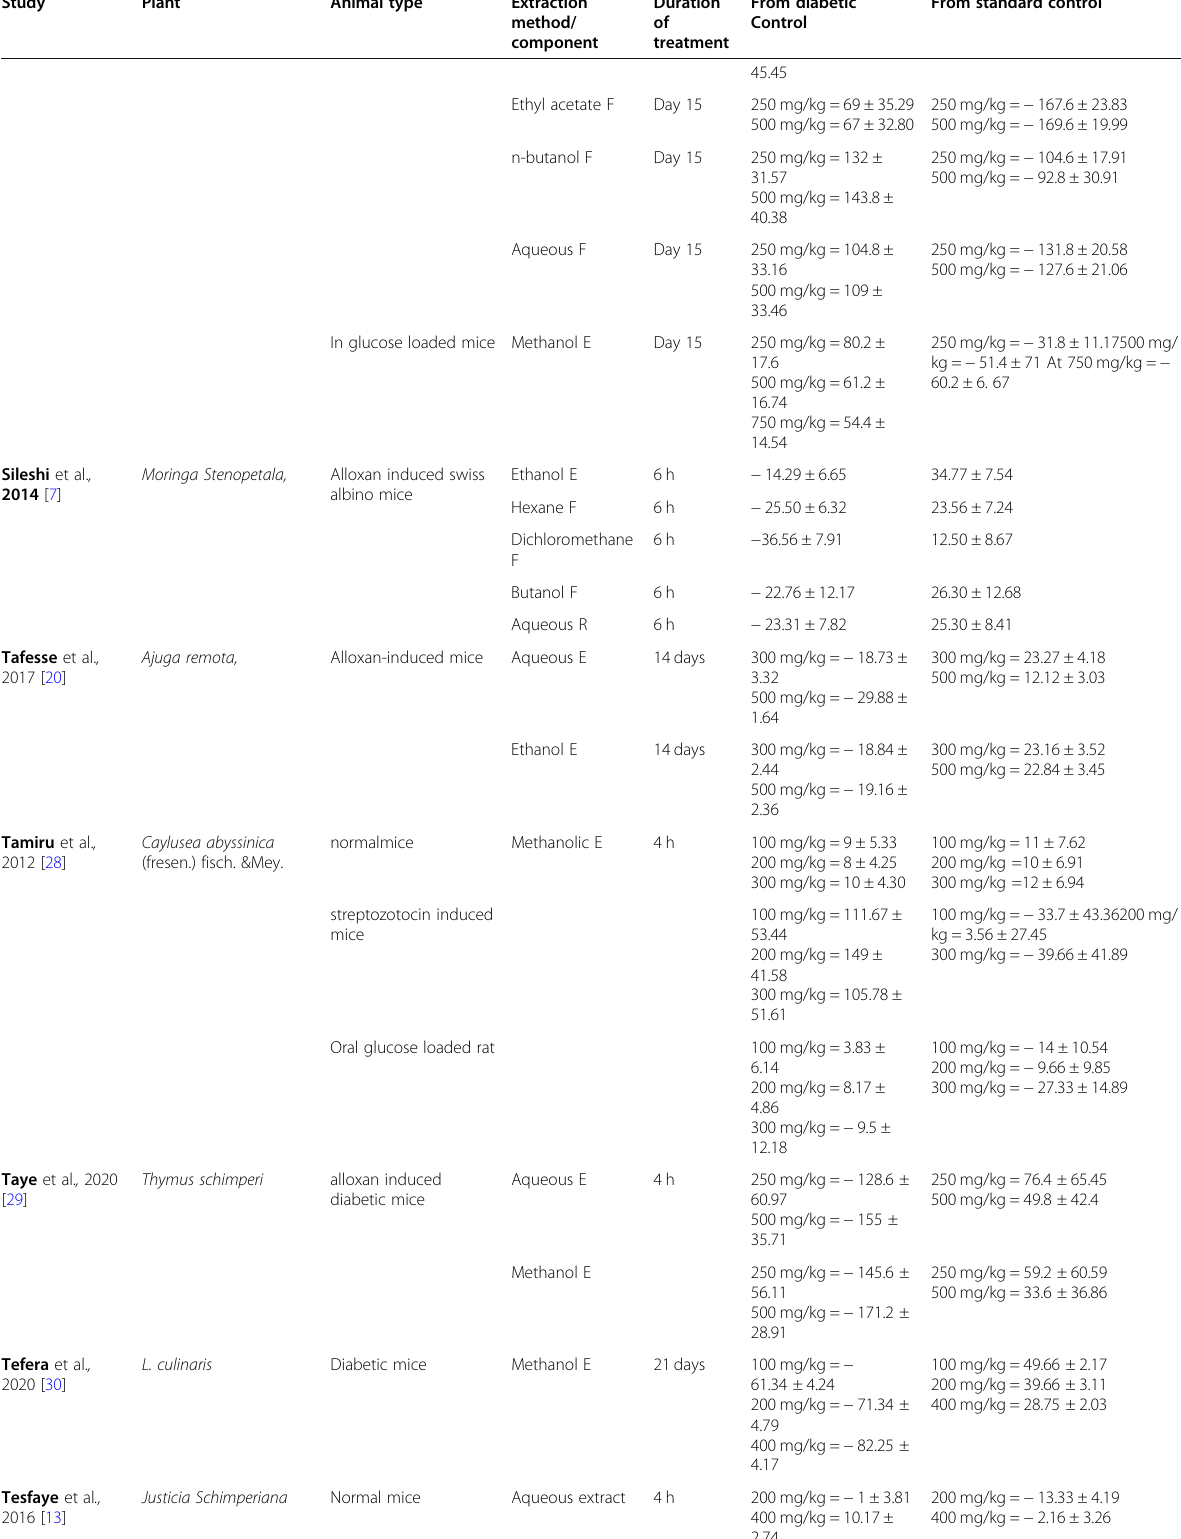
Table 3 In vivo anti-diabetic activity of medicinal plat in Ethiopia (Continued)